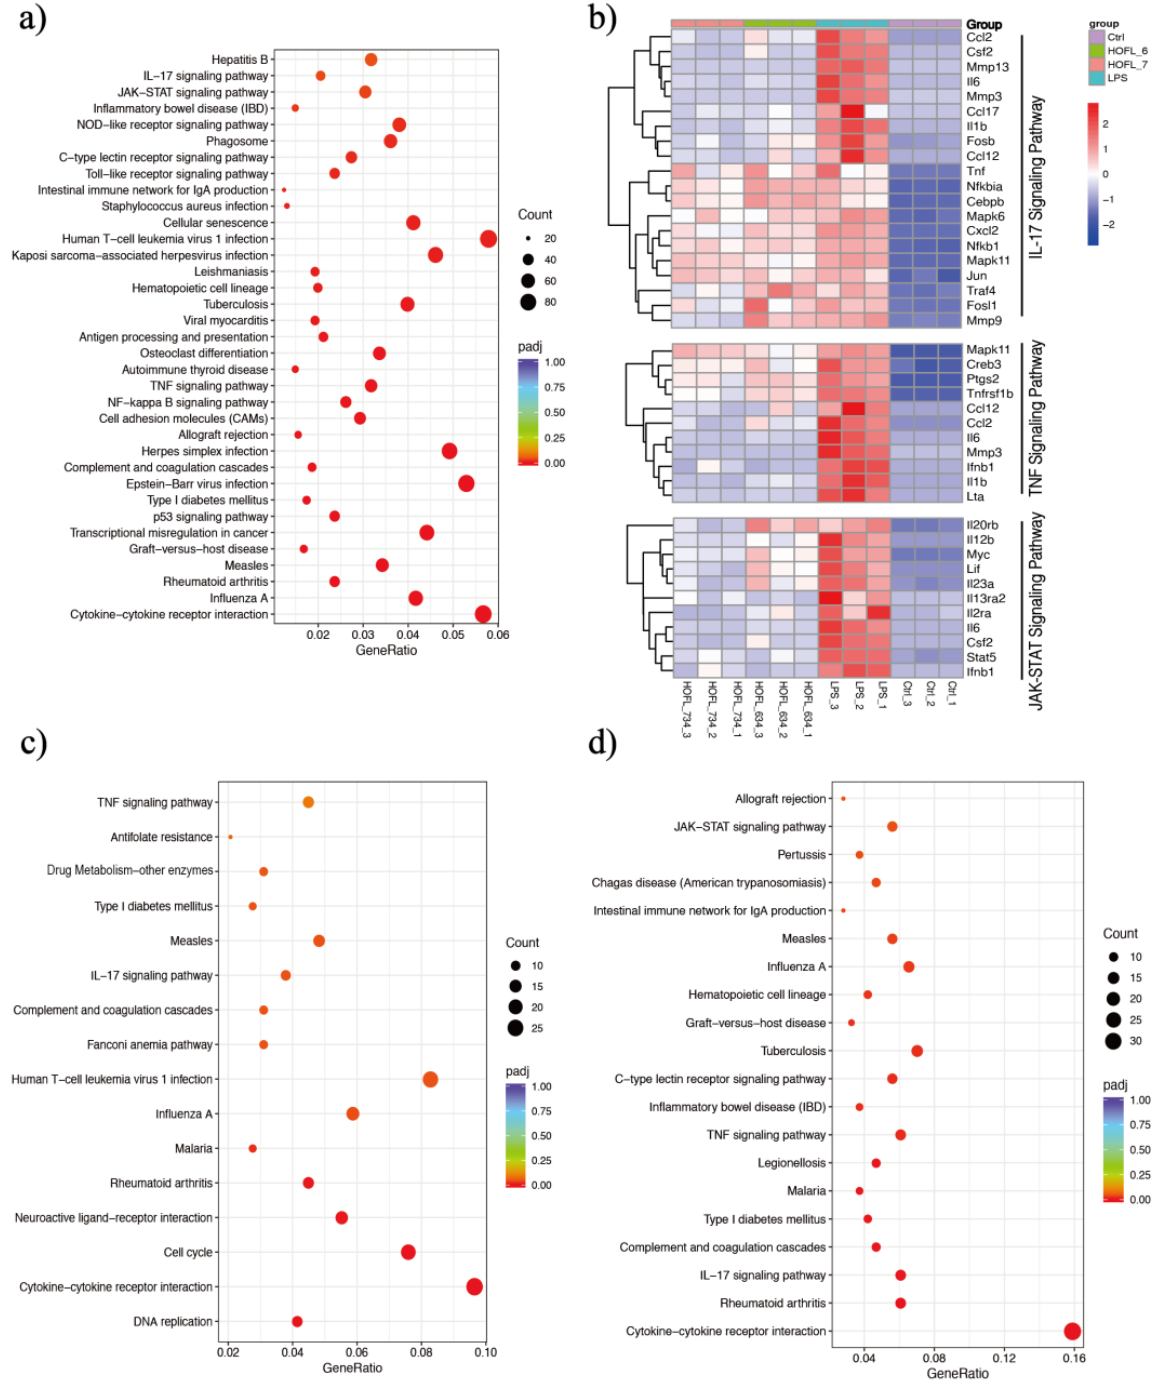
Figure 4. 6,3’,4’- and 7,3’,4’-HOFL exert anti-inflammatory activity via IL-17, TNF, and JAK-STAT pathways. KEGG enrichment scatter plots of DEGs of LPS vs. Ctrl ( a ), 6,3’,4’-HOFL vs. LPS ( c ), and 7,3’,4’-HOFL vs. LPS ( d ). Clustering heatmap of DEGs involved in IL-17, TNF, and JAK-STAT pathways ( b ).